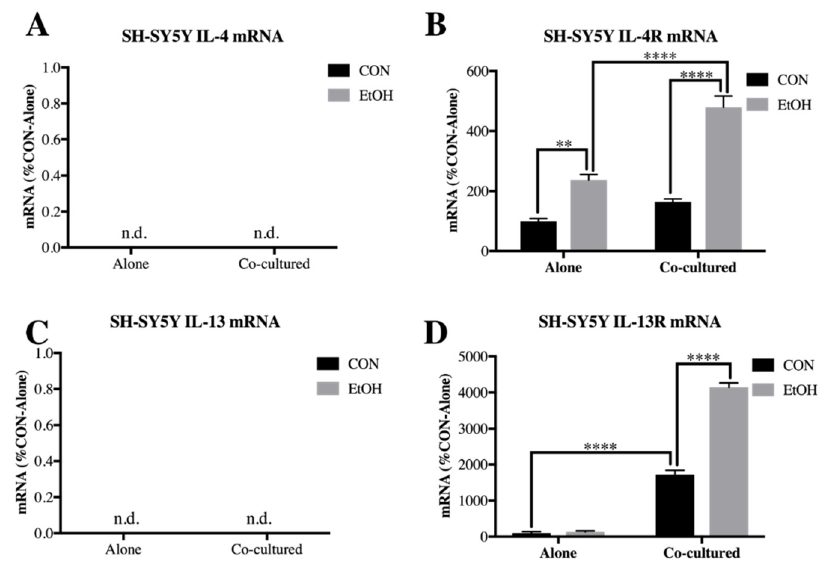
Figure 6. IL-4R and IL-13R is increased by ethanol in co-cultured SH-SY5Y. SH-SY5Y were treated with ethanol (EtOH, 100 mM) for 24 h either alone or while co-cultured with BV2 microglia. Cell lysates were examined for mRNA expression. ( A ) IL-4 expression was not detected in SH-SY5Y. ( B ) IL-4R was increased by EtOH in SH-SY5Y alone (238 ± 18%), as well as by EtOH in co-cultured SH-SY5Y (480 ± 37%). ( C ) IL-13 expression was not detected in SH-SY5Y. ( D ) IL-13R was increased in co-cultured SH-SY5Y (1723 ± 117%), as well as by EtOH in co-cultured SH-SY5Y (4147 ± 119%). Data is represented as %CON (control)-Alone ± SEM, n = 5–6 per group. n.d. = not detected ( > 40 cycles). ** p < 0.01, **** p < 0.0001 vs. indicated group via Bonferroni’s post-hoc following 2-way ANOVA.